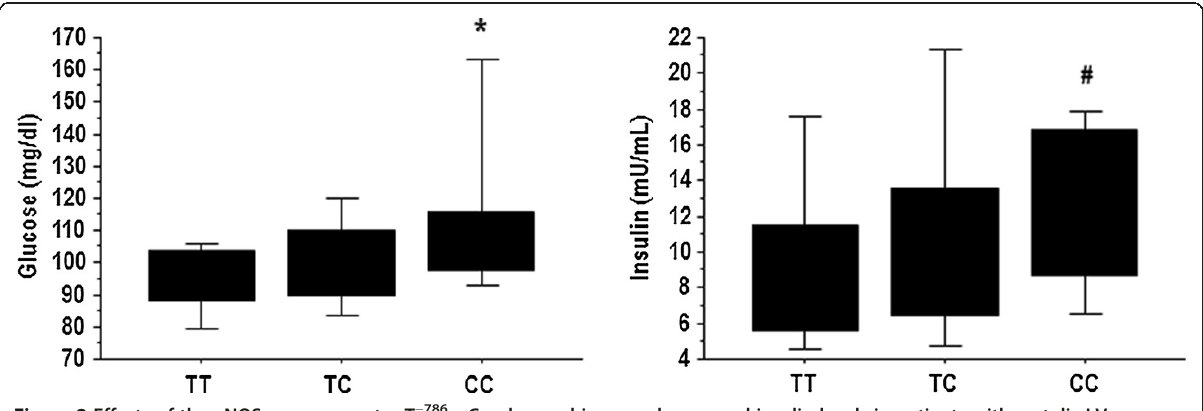
Figure 2 Effects of the eNOS gene promoter T − 786 → C polymorphism on glucose and insulin levels in patients with systolic LV dysfunction. *p=0.005 CC vs TT; #p<0.05 CC vs